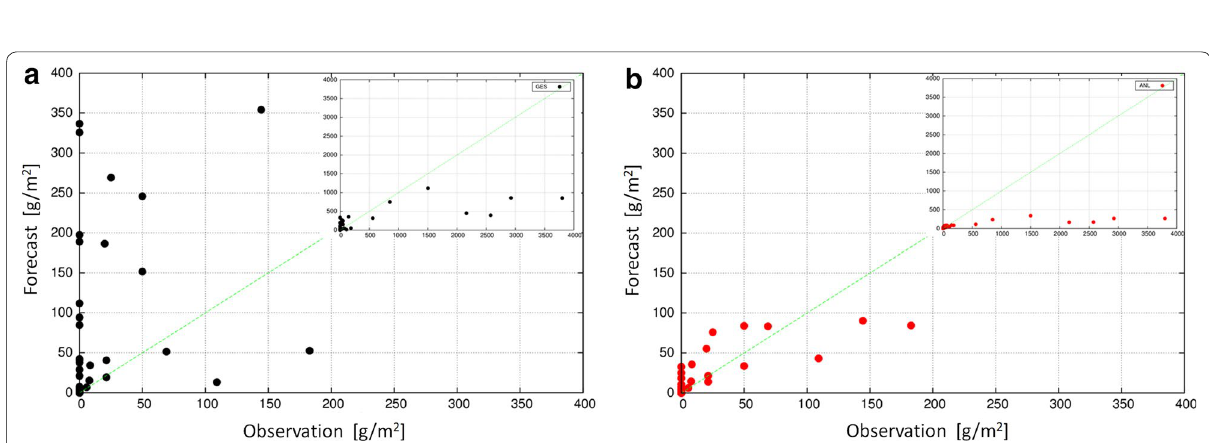
Fig. 4 Comparison between observation and simulation for ash fall and lapilli. a Without 4D-Var. b With 4D-Var. Small windows in both figures are enlargements of large regions (0–4000 g/m 2